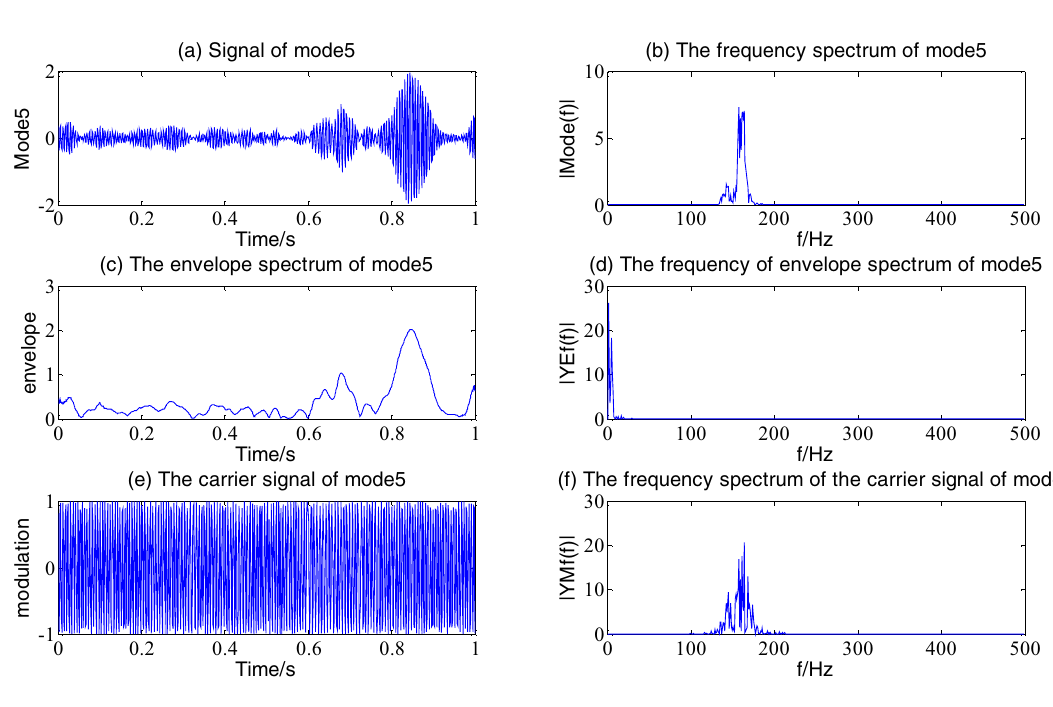
Figure 5. The envelope demodulation distribution diagram of